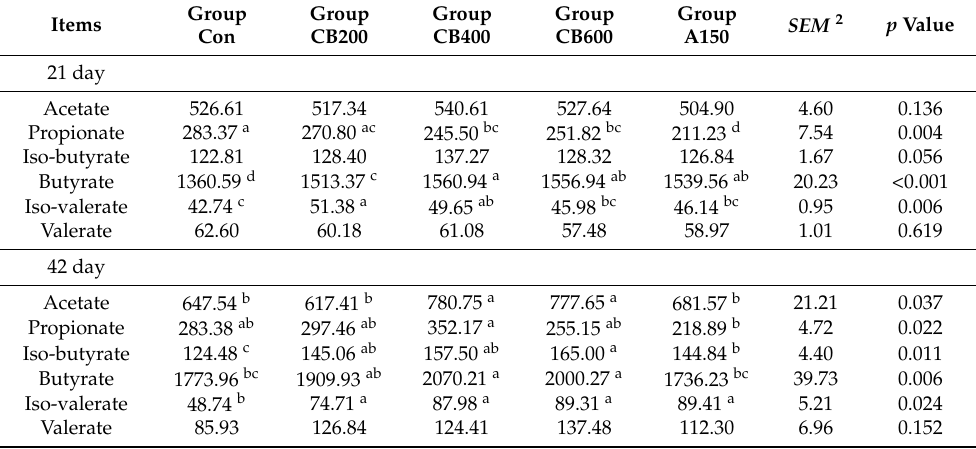
Table 3. Influence of Clostridium butyricum and aureomycin supplementation on short-chain fatty acids concentrations of Pekin ducks 1 ( µ